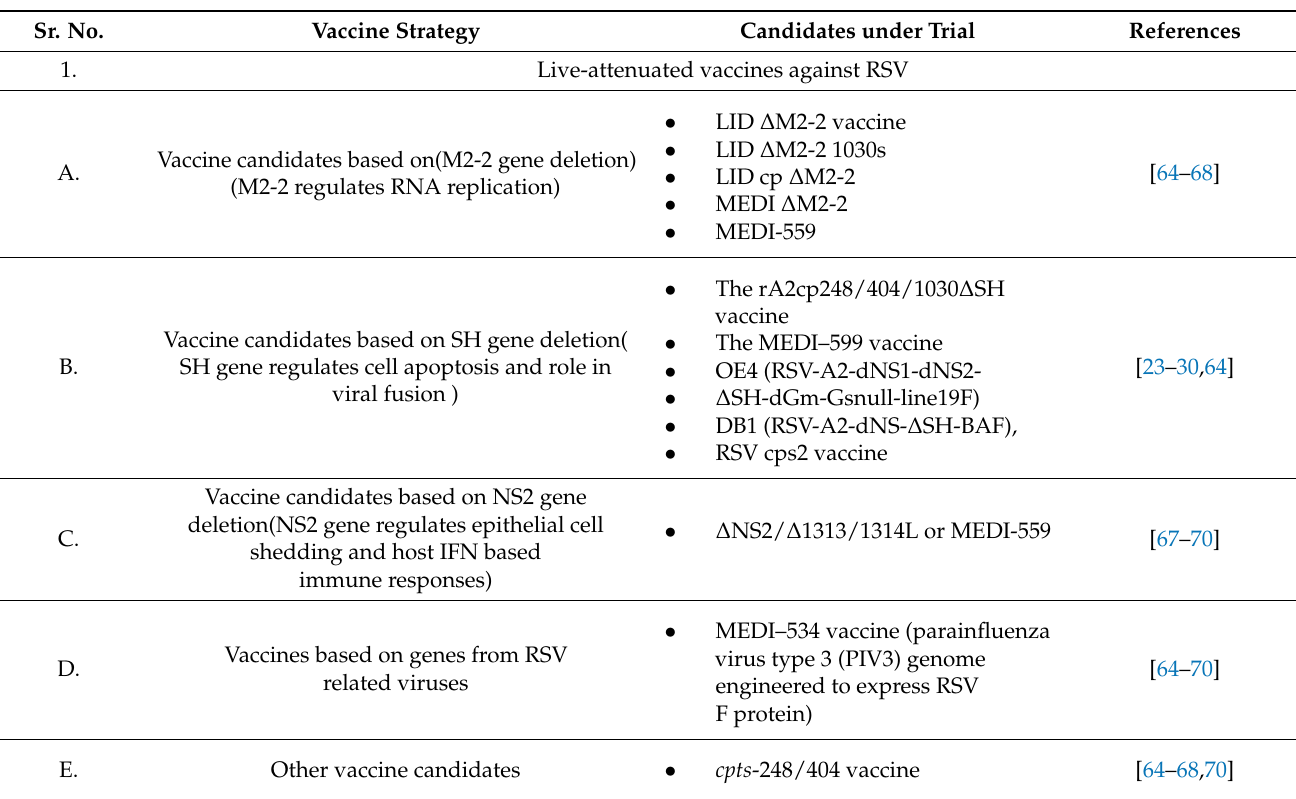
Table 1. Vaccines against RSV under clinical